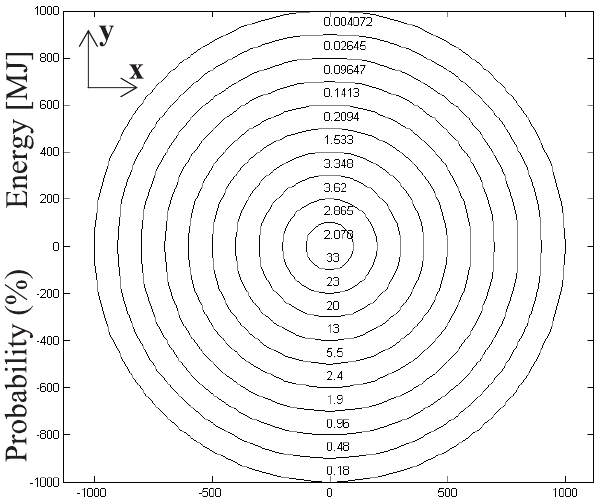
Fig. 6. Arriving fragment probability and their energy.